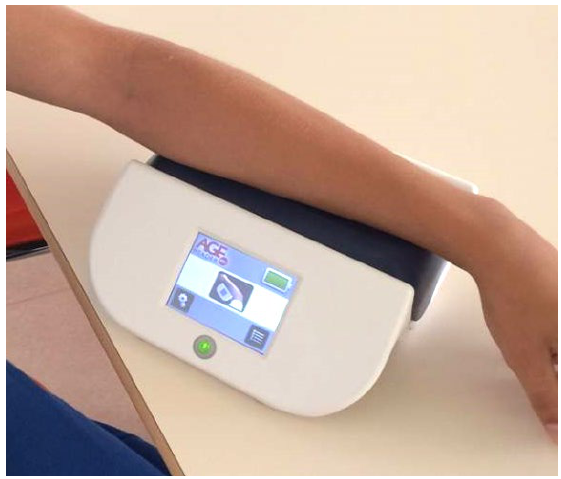
Figure 2. Practical measurement of skin autofluorescence .